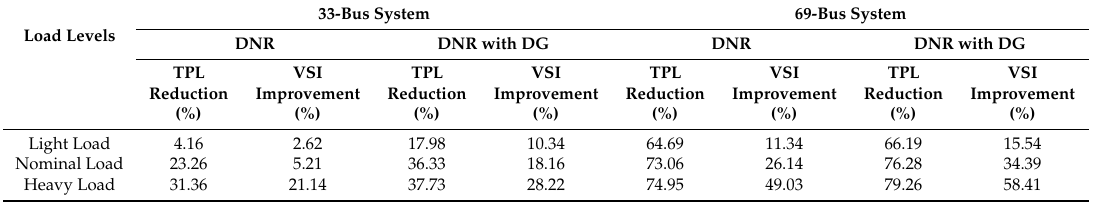
Table 8. Total power losses reduction and VSI improvement for IEPSO